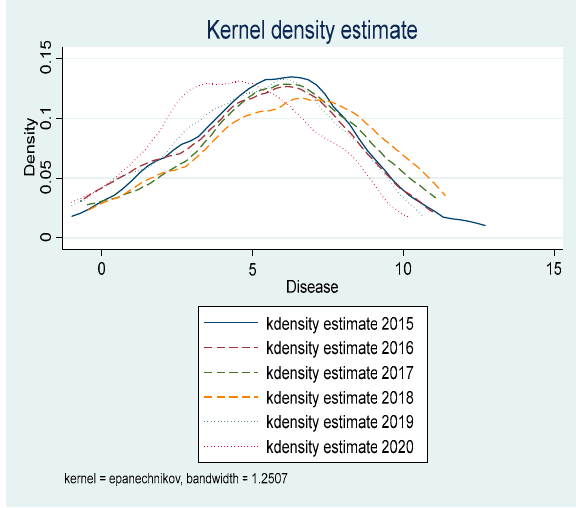
Figure 2. Dynamic evolution trend of the incidence of major diseases.